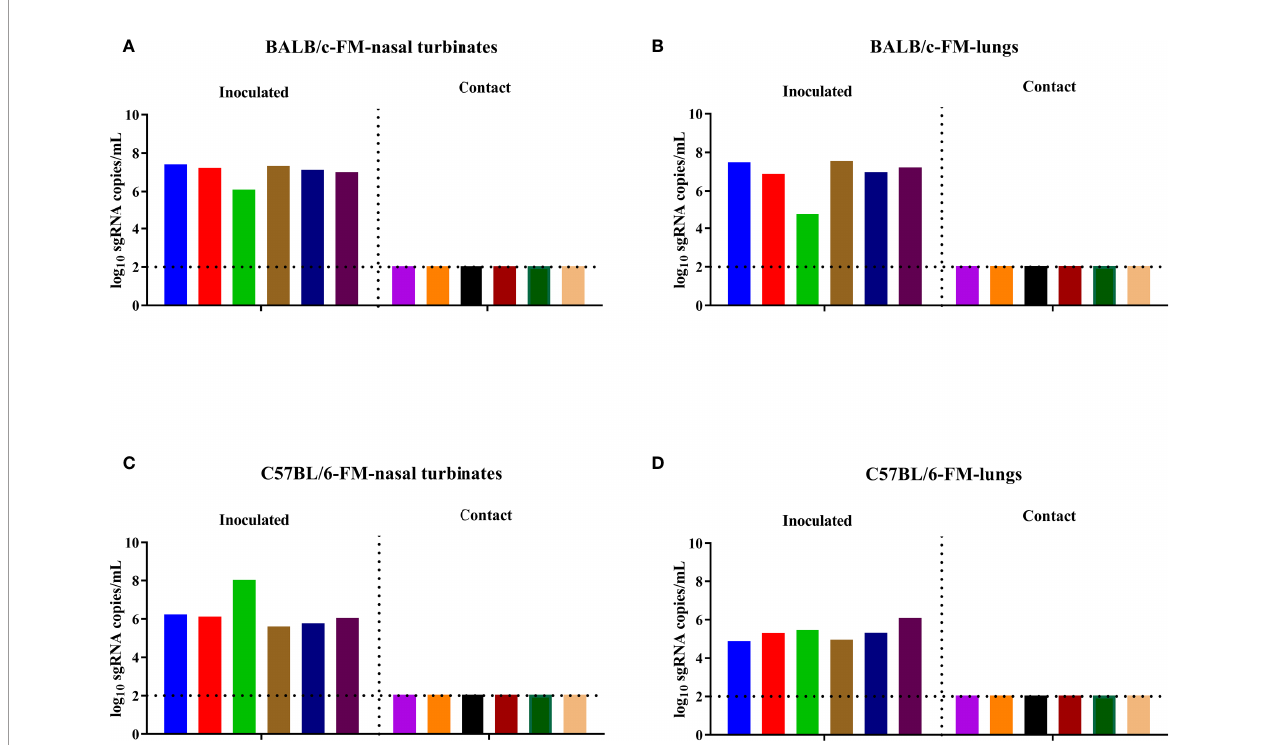
FIGURE 2 | SARS-CoV-2 B.1.351 variant transmission in female BALB/c and female C57BL/6 mice. The dotted line represents the detection limit. Viral sgRNA copies (log